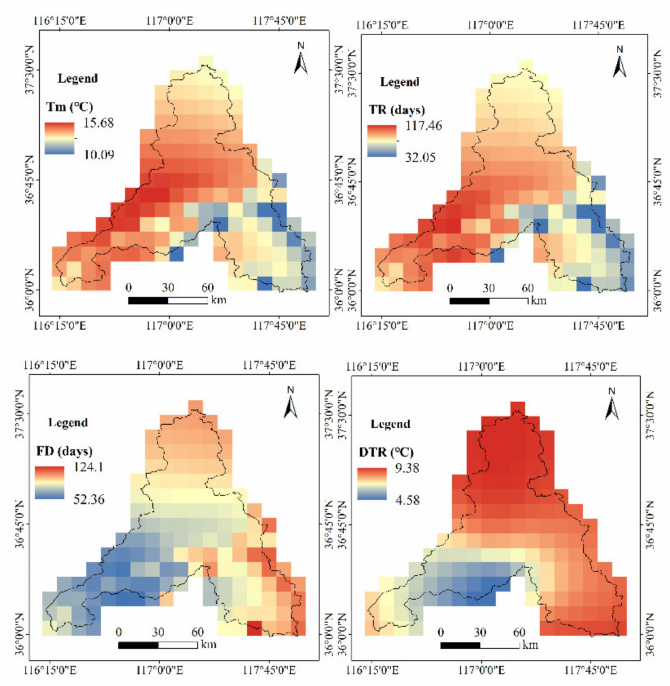
Figure 4. Spatial distribution of temperature indices in Jinan City during the period of